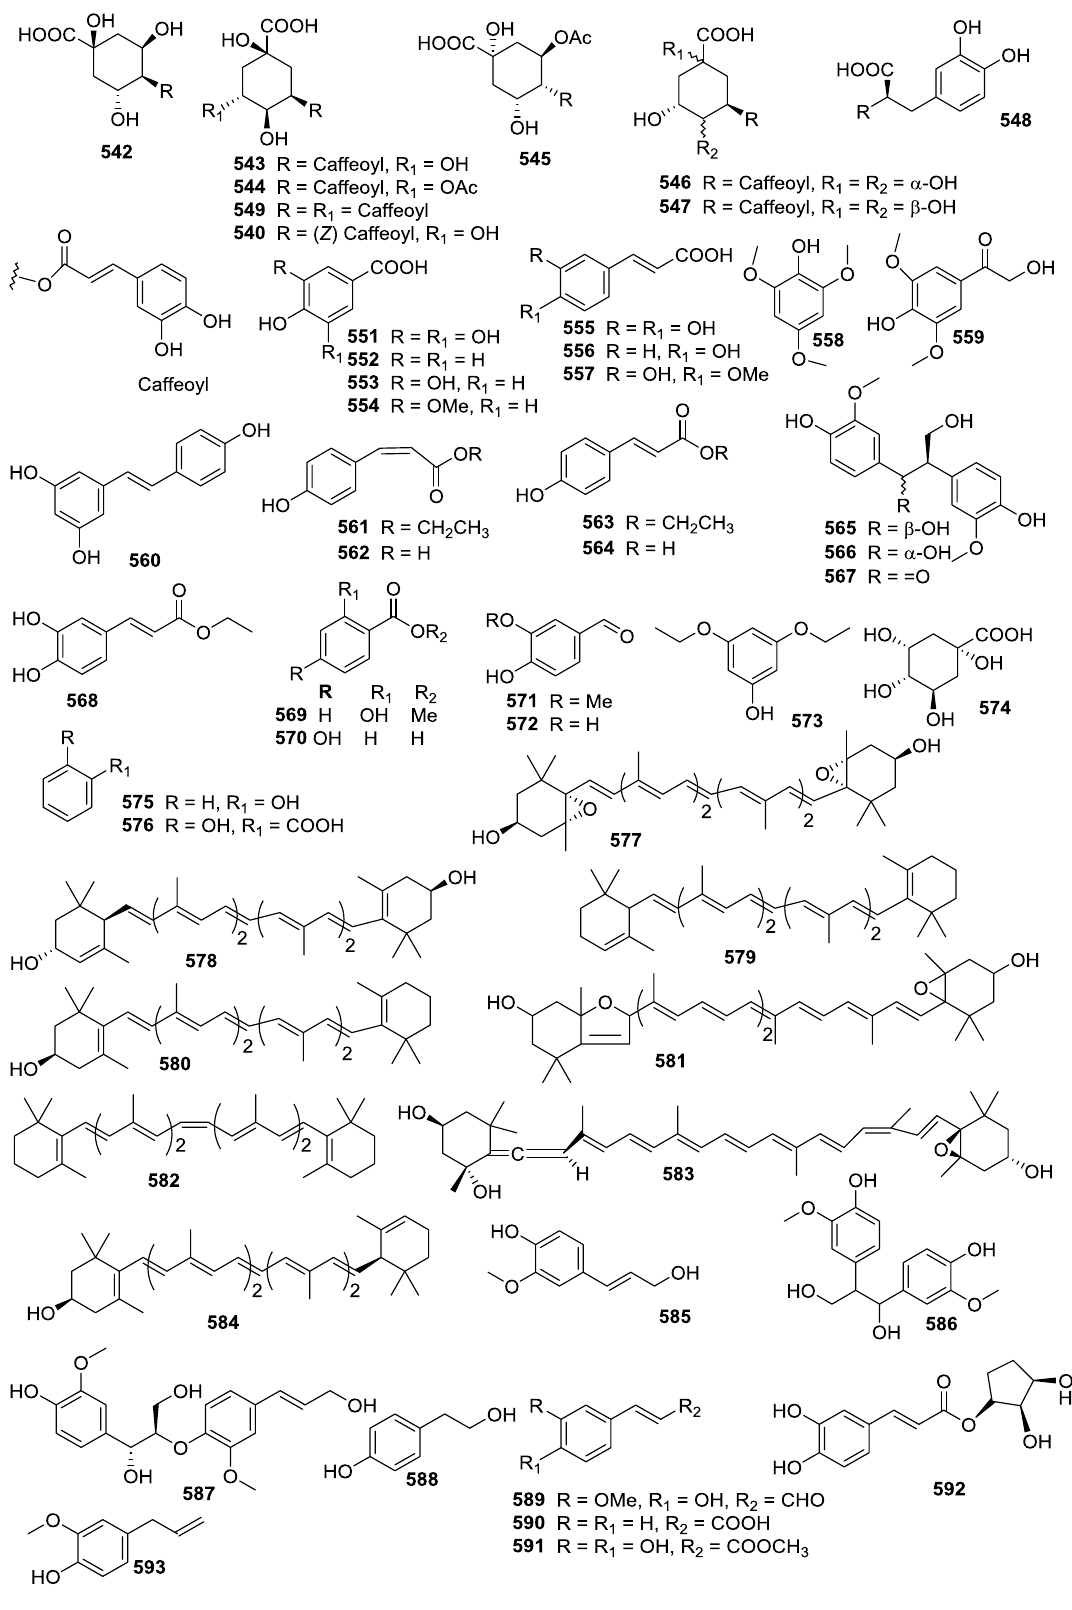
Fig. 12 Phenolic compounds 542 – 593 from